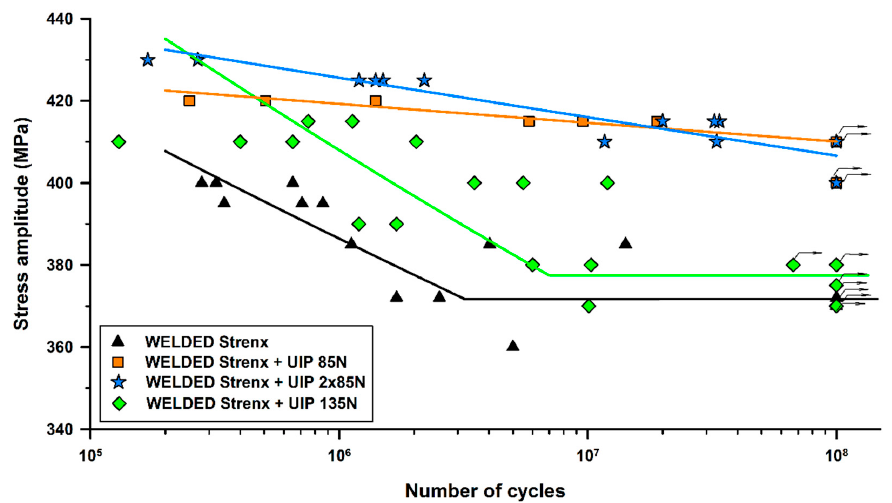
Figure 11. S–N curves of Strenx 700 MC welded joints before and after application of the UIP with different parameters.